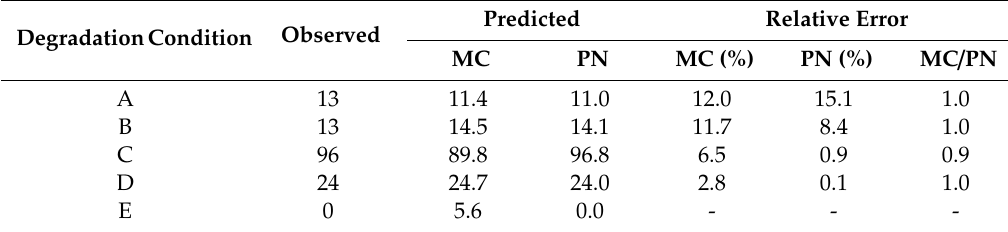
Table 4. Predicted and observed CCPR in the di ff erent degradation conditions, as well as the respective relative error obtained by Markov chains (MC) and the Petri net (PN) with transitions exponentially distributed.